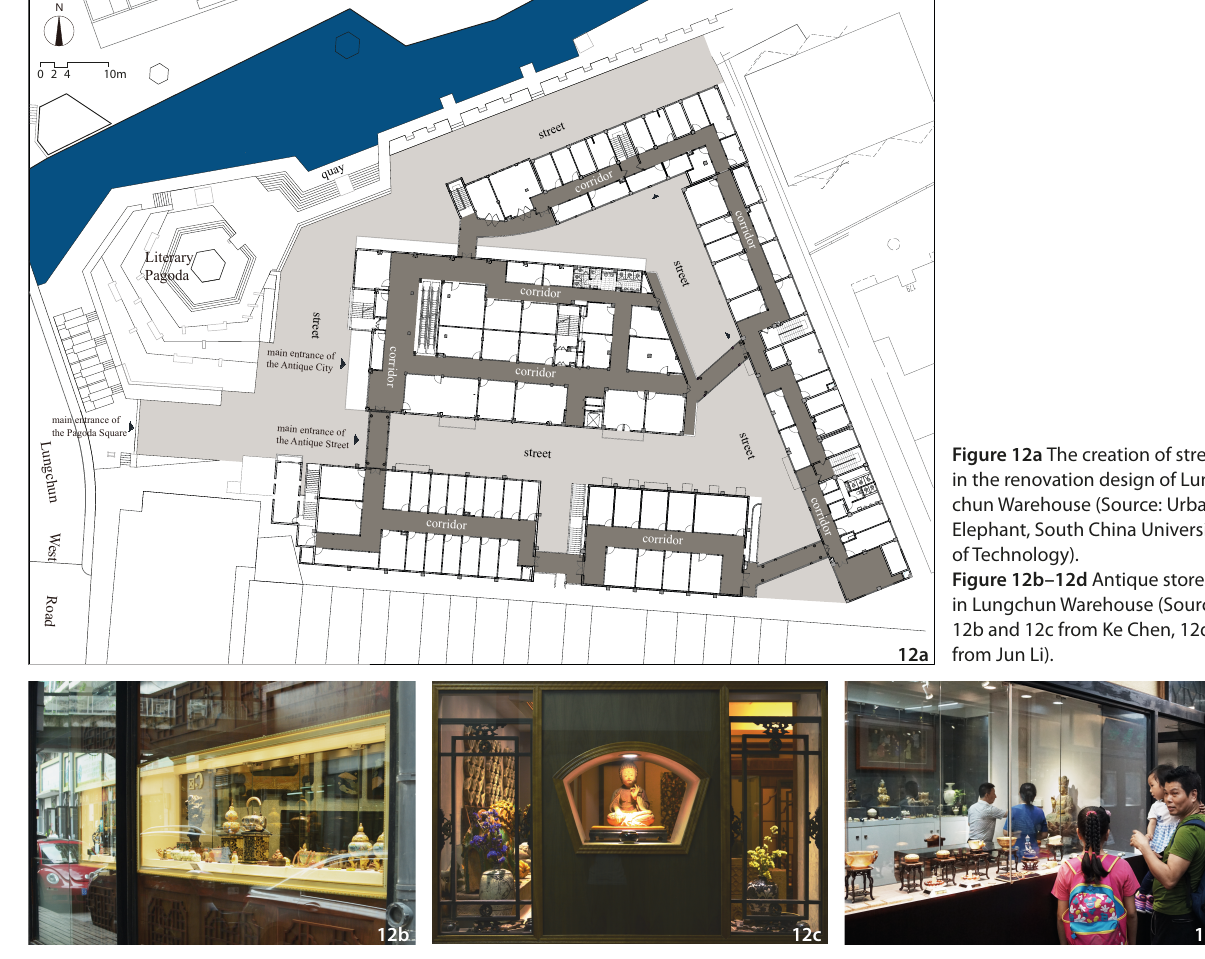
Figure 12a The creation of streets in the renovation design of Lung- chun Warehouse (Source: Urban Elephant, South China University of Technology). Figure 12b–12d Antique stores in Lungchun Warehouse (Source: 12b and 12c from Ke Chen, 12d from Jun